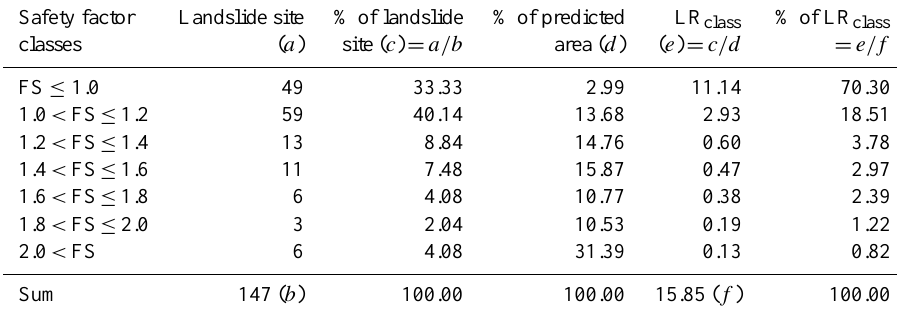
Table 4. Summary of TRIGRS results in landslide simulations Safety factor Landslide site % of landslide % of predicted LR class % of LR class